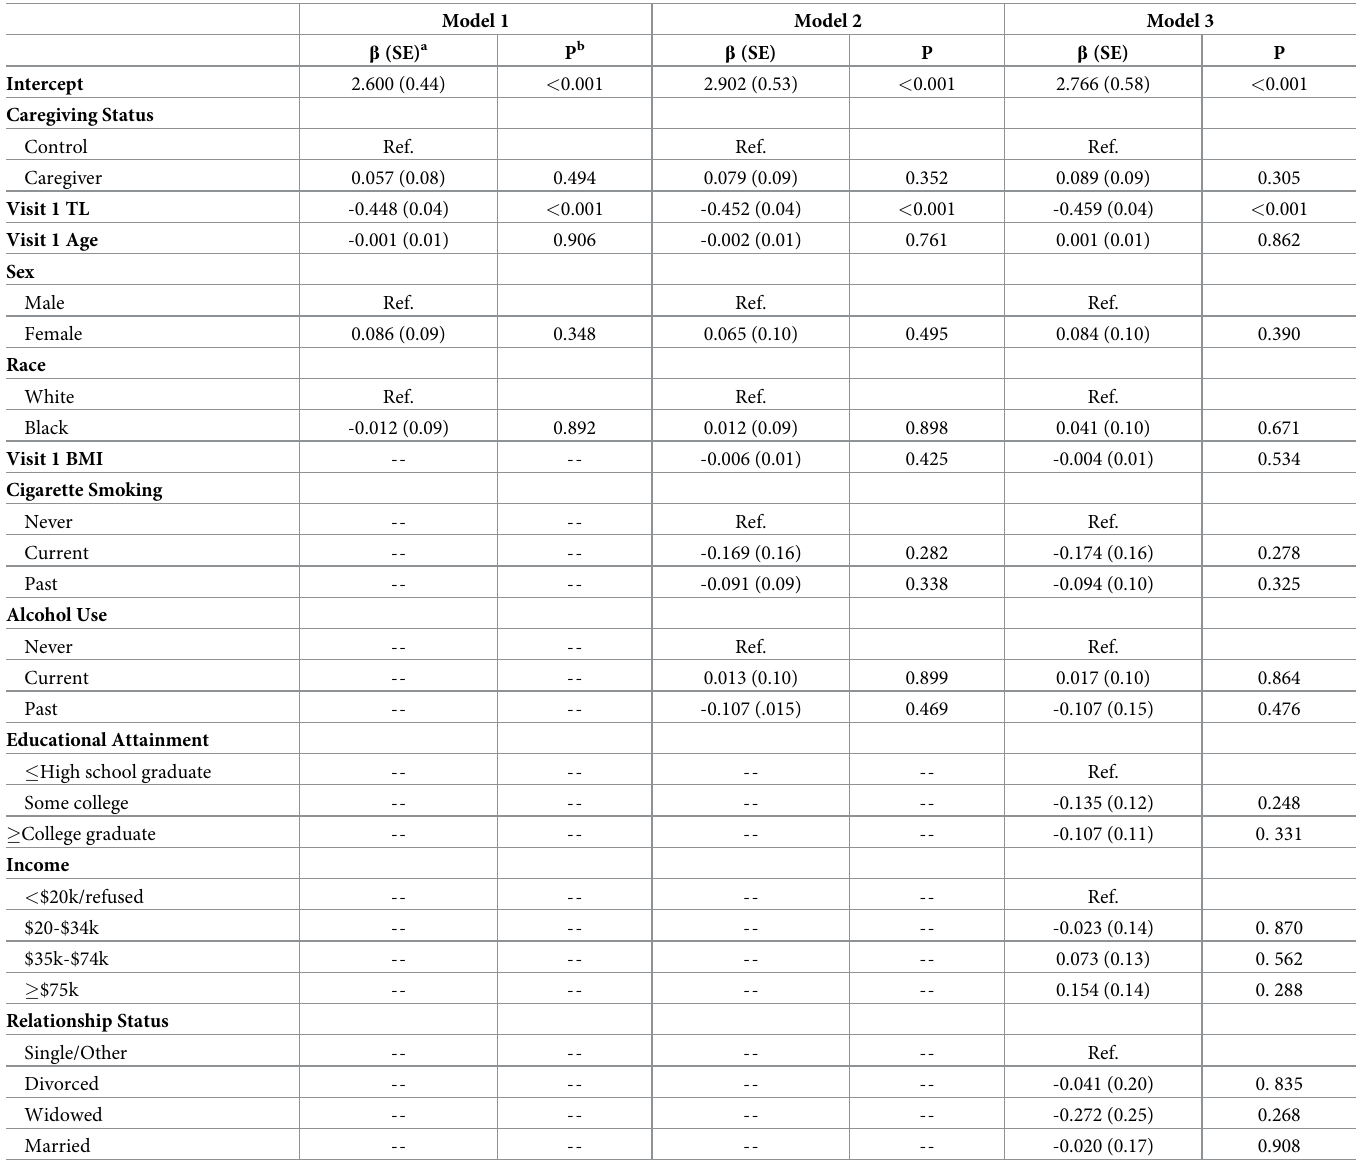
Table 2. Effects of caregiving status on the change in TL ( Δ